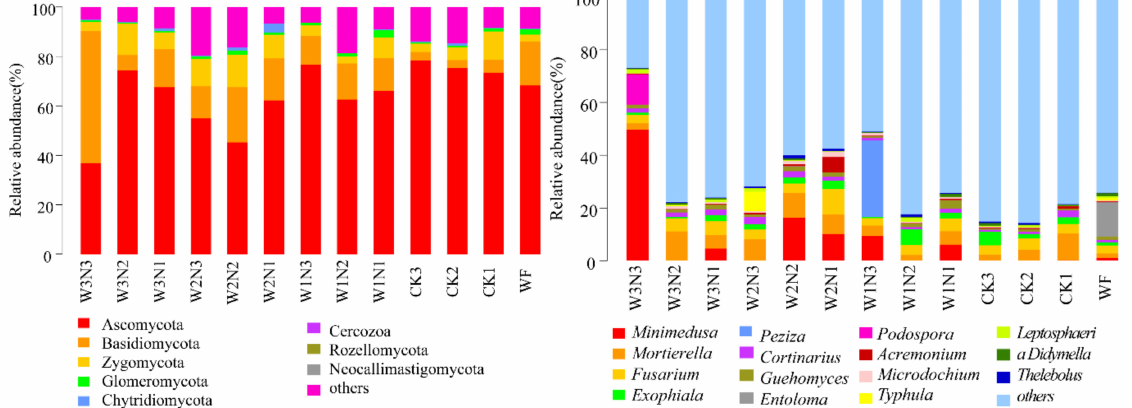
Figure 2. Differences in the taxonomic composition of soil fungi at the phyla and genus